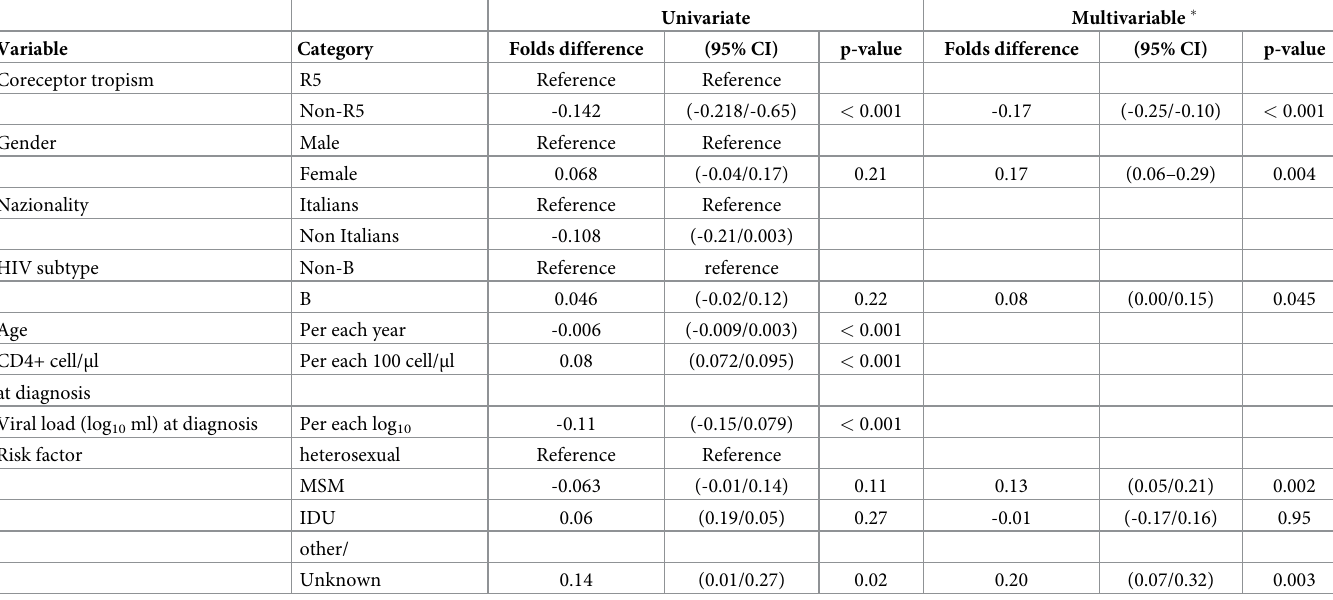
Table 4. Association between patients’ and viral characteristics and the CD4/CD8